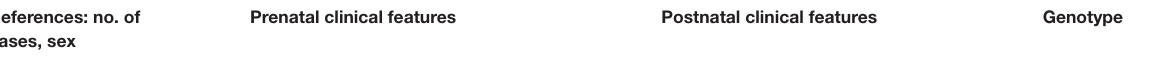
TABLE 1 | Summary of reported to date cases with Fryns syndrome phenotype due to glycosylphosphatidylinositol biosynthesis defects